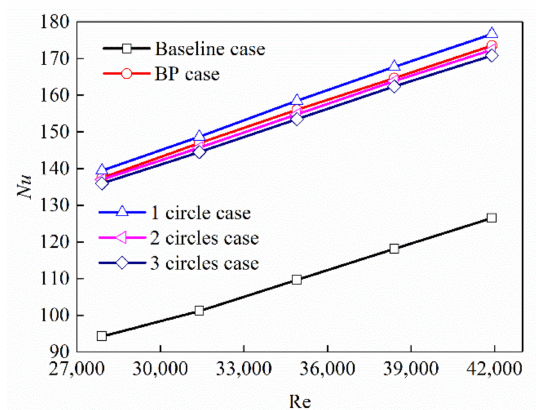
Figure 17. Variation of Nu with Re in the shell